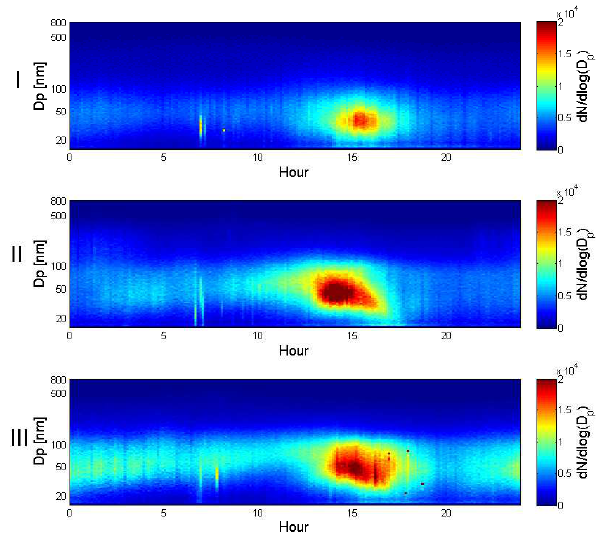
Fig. 2. Average diurnal DMA number concentrations (cm − 3 ) for regimes I, II, and